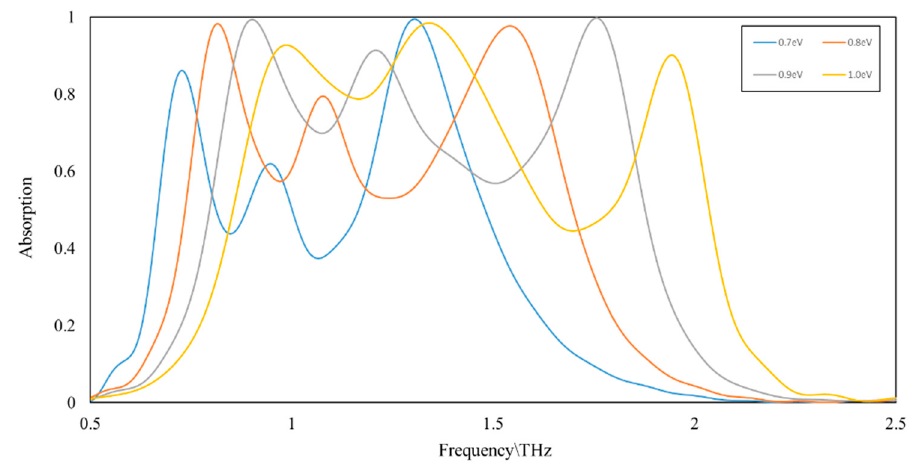
Figure 2. The simulated absorption spectrum of the absorber which the Graphene at the different Fermi levels (blue line is E f = 0.7 eV, orange line is E f = 0.8 eV, gray line is E f = 0.9 eV, yellow line is E f = 1.0 eV).